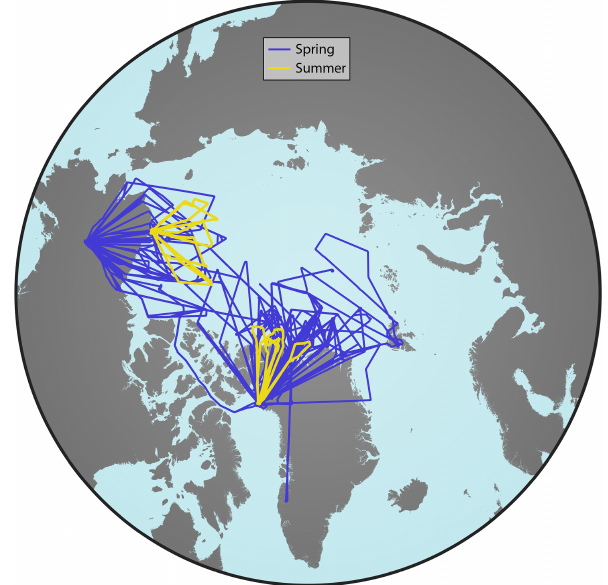
Figure 1. Plot of all flights processed with OSSP, colored by the melt conditions during the flight. Spring freezing conditions are shown in blue, and summer melting conditions are shown in yel- low. Coastline data were derived from © OpenStreetMap